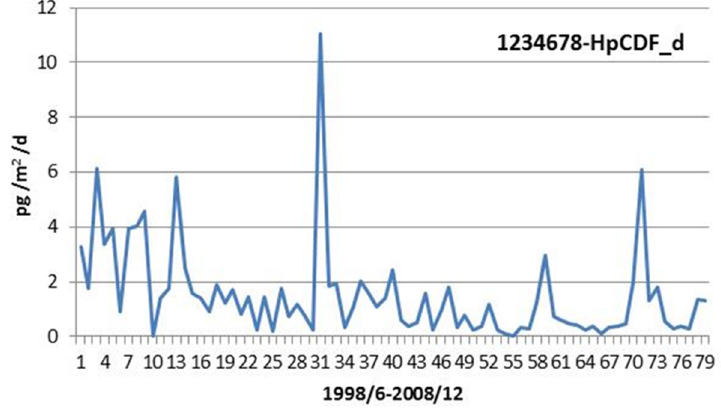
Figure 2. Visual Basic program for multivariate Mann ‐ Kendall tests of monotone trends in time series of data grouped by sites, plots, and seasons, to evaluate the possible trends using Evo results, was used and the trend of 1,2,3,4,6,7,8 ‐ HpCDF pg ∙ m − 2 ∙ day − 1 are presented in these figures.